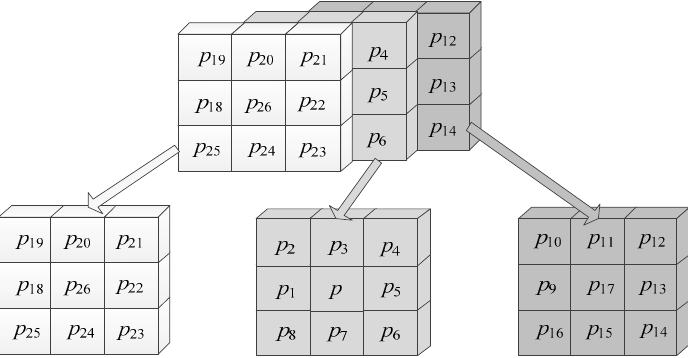
Figure 1. Illustration for explaining di ff erent adjacency among voxels.